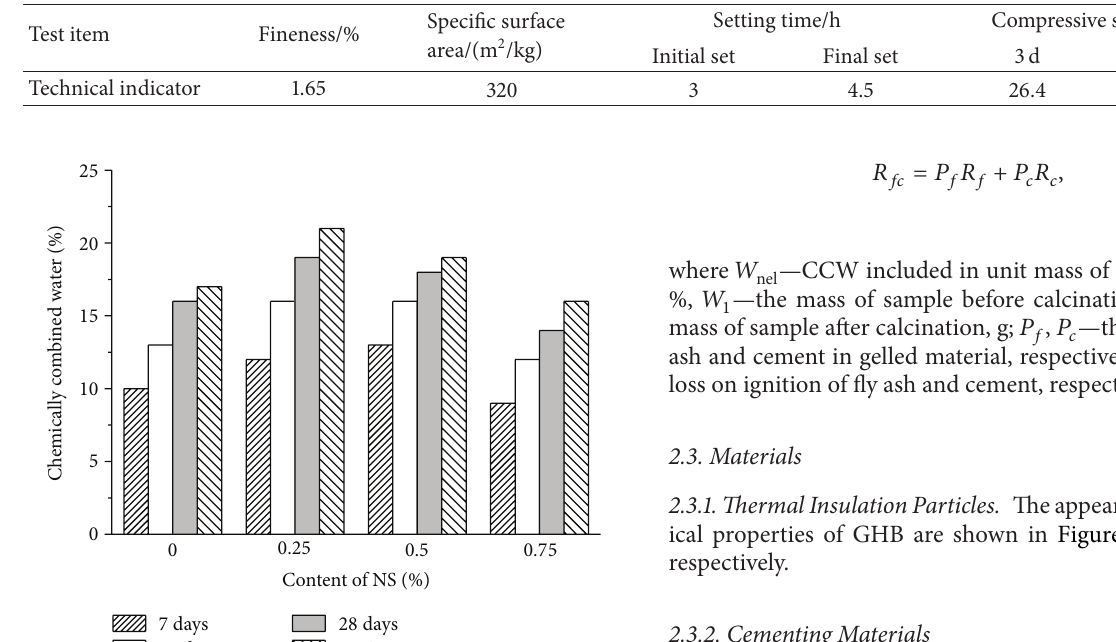
Table 2: The chemical composition of cement.